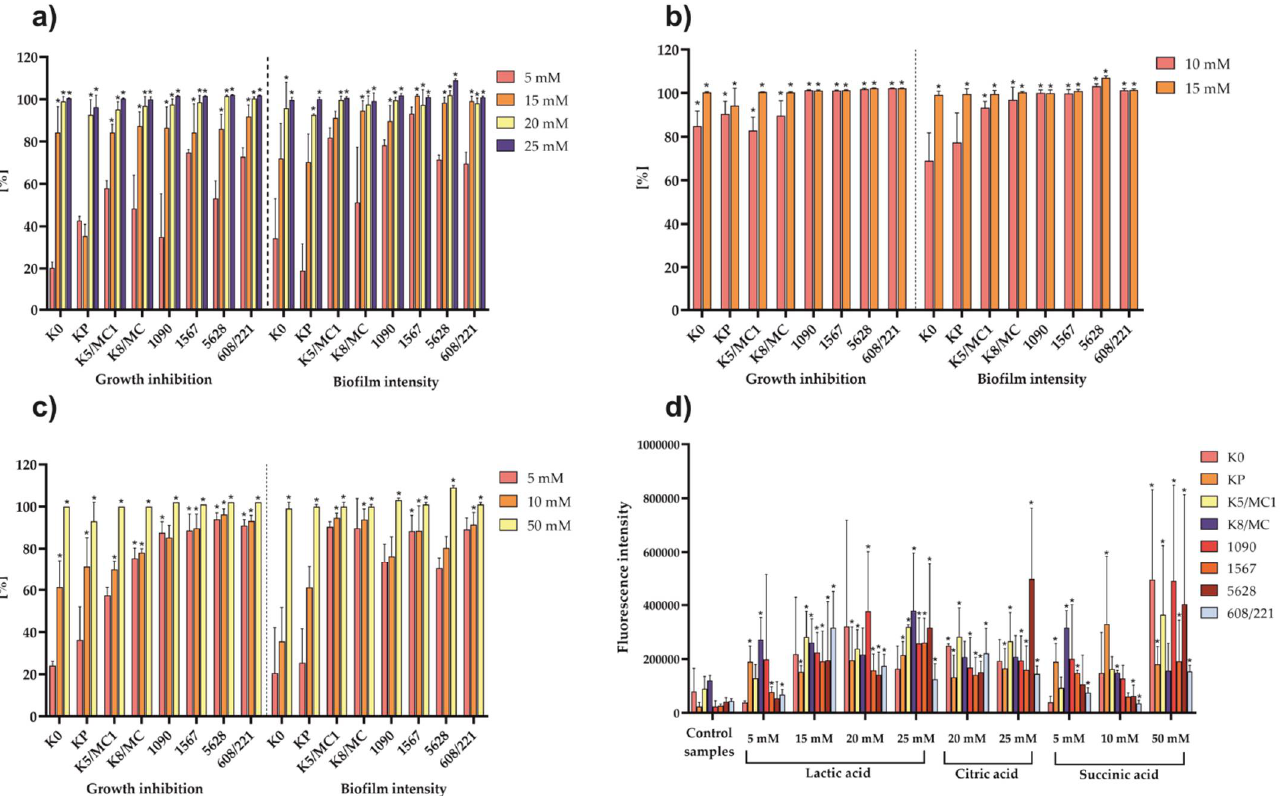
Figure 4. The percentage of P. mirabilis strain growth and biofilm formation inhibition by lactic acid ( a ), citric acid ( b ), and succinic acid ( c ). The results are presented as the mean ± standard deviation (SD) of three experiments. * p < 0.05 for comparison of bacterial growth in the presence of tested organic acids vs. P. mirabilis culture without organic acids, according to Cochran’s Q test. ( d ) The fluorescence intensity of P. mirabilis in the control culture (without acids) vs. that in the culture incubated with different concentration of organic acids. The results are presented as the mean ± standard deviation (SD) of four experiments. * p < 0.05 for comparison of fluorescence intensity of P. mirabilis treated with acids vs. pure P. mirabilis culture, according to U Mann–Whitney test .